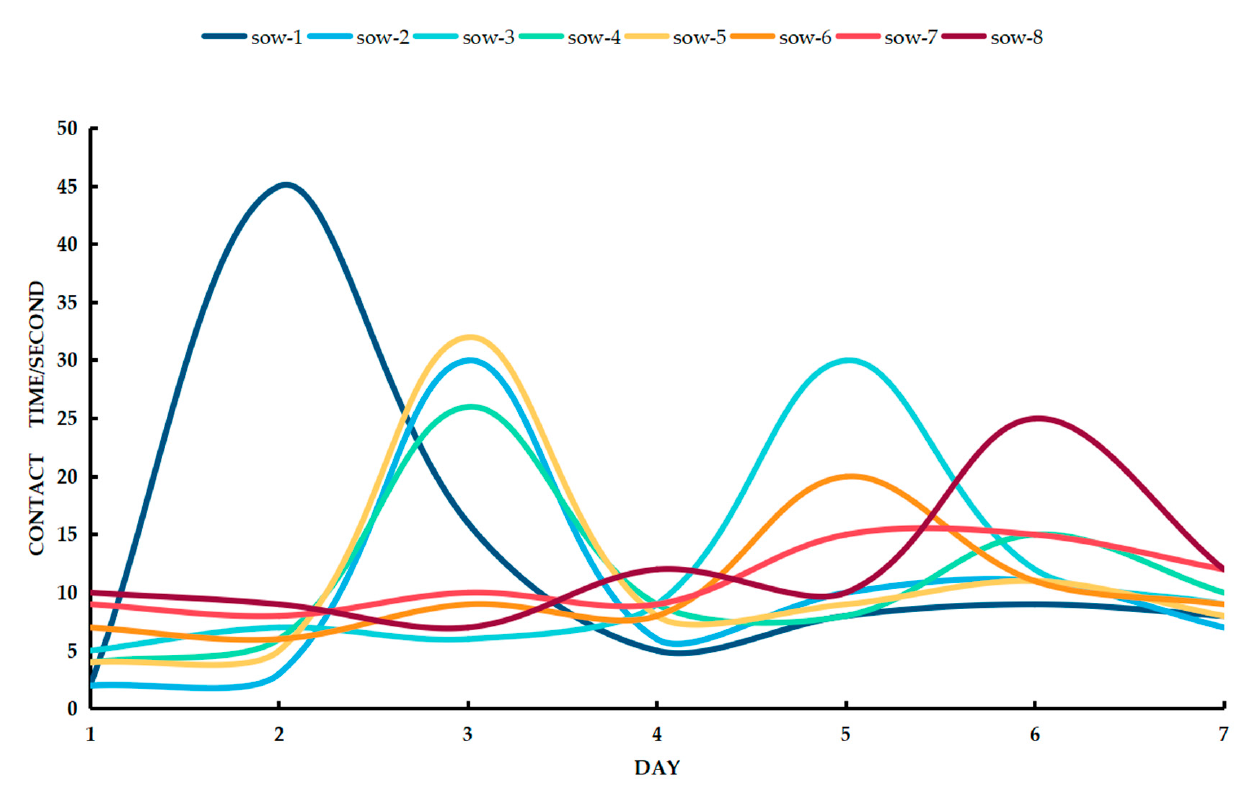
Figure 6. The contact duration between the sow and the bionic boar 1–7 days after weaning (a single sow check lasts three minutes).